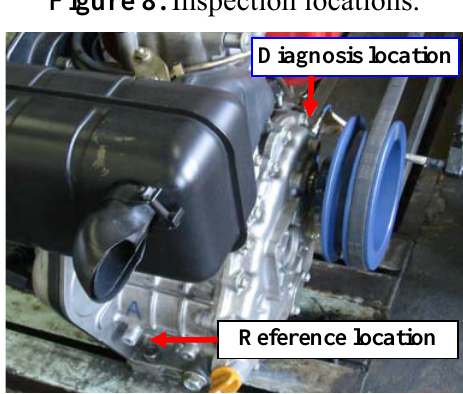
Figure 8. Inspection